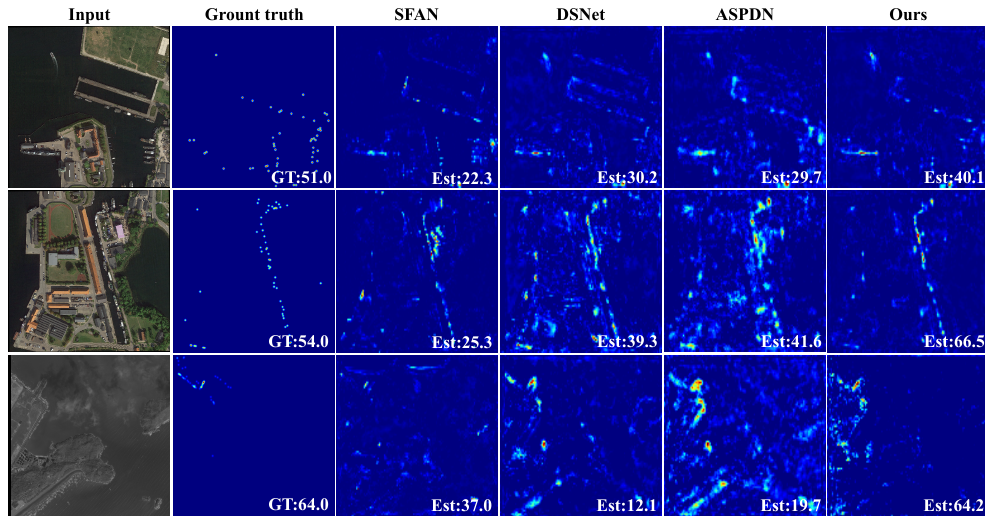
Figure 9. Subjective comparisons of different models on the RSOC_ship subdataset.